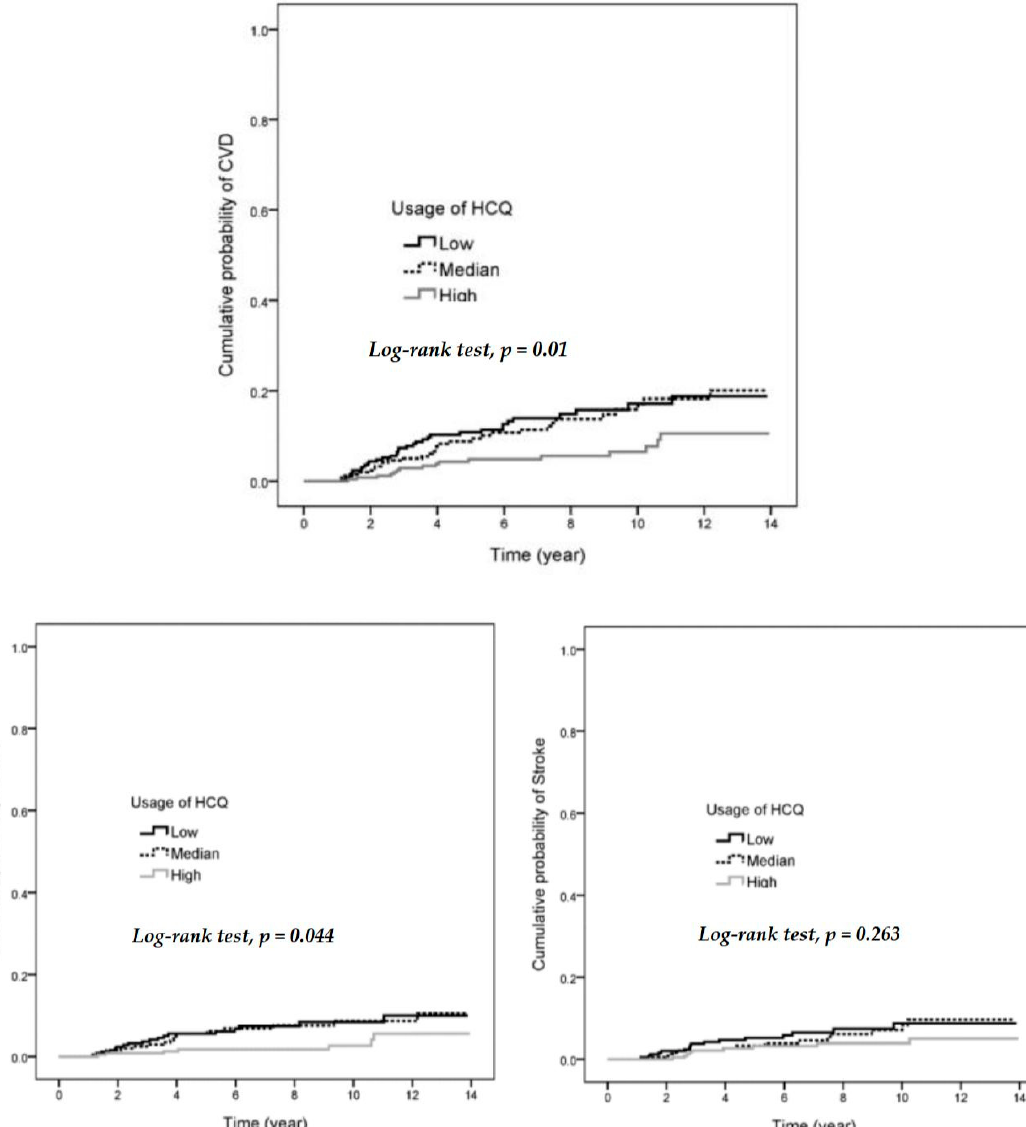
Figure 2. Cumulative probability of CVD, CAD, and stroke in low, median, and high usage of HCQ. CAD: coronary artery disease.